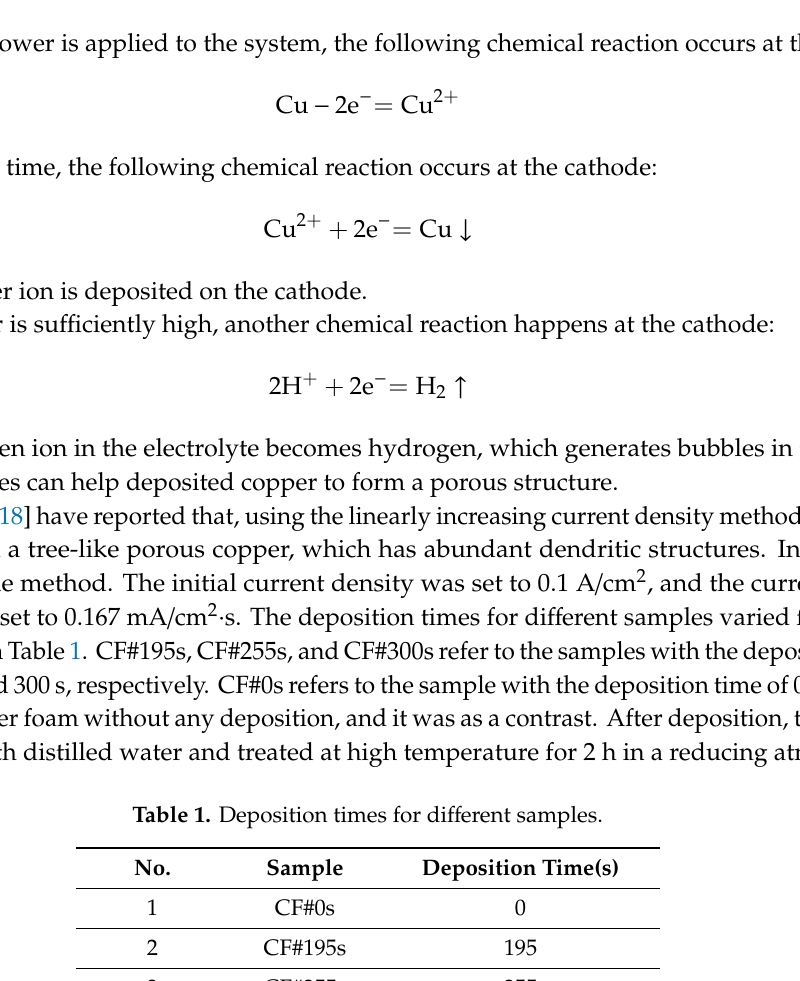
Figure 1. Experimental setup for the preparation of electrodeposition-patterned copper foam.